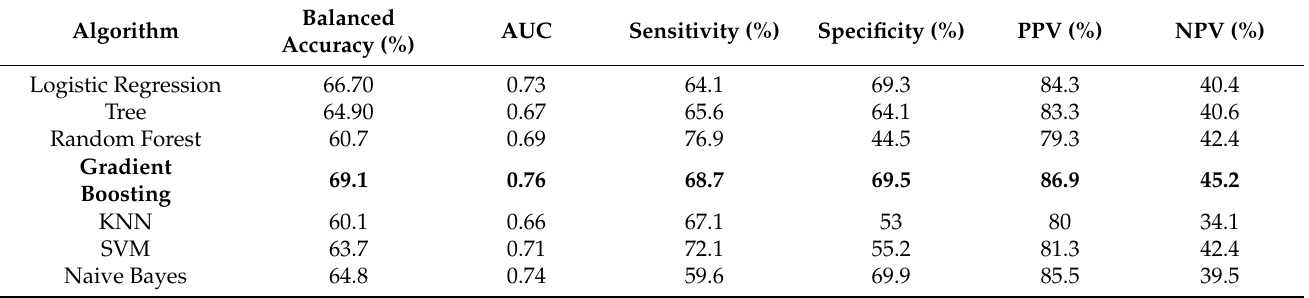
Table 2. Machine Learning Models and their performance in nested cross-validation.